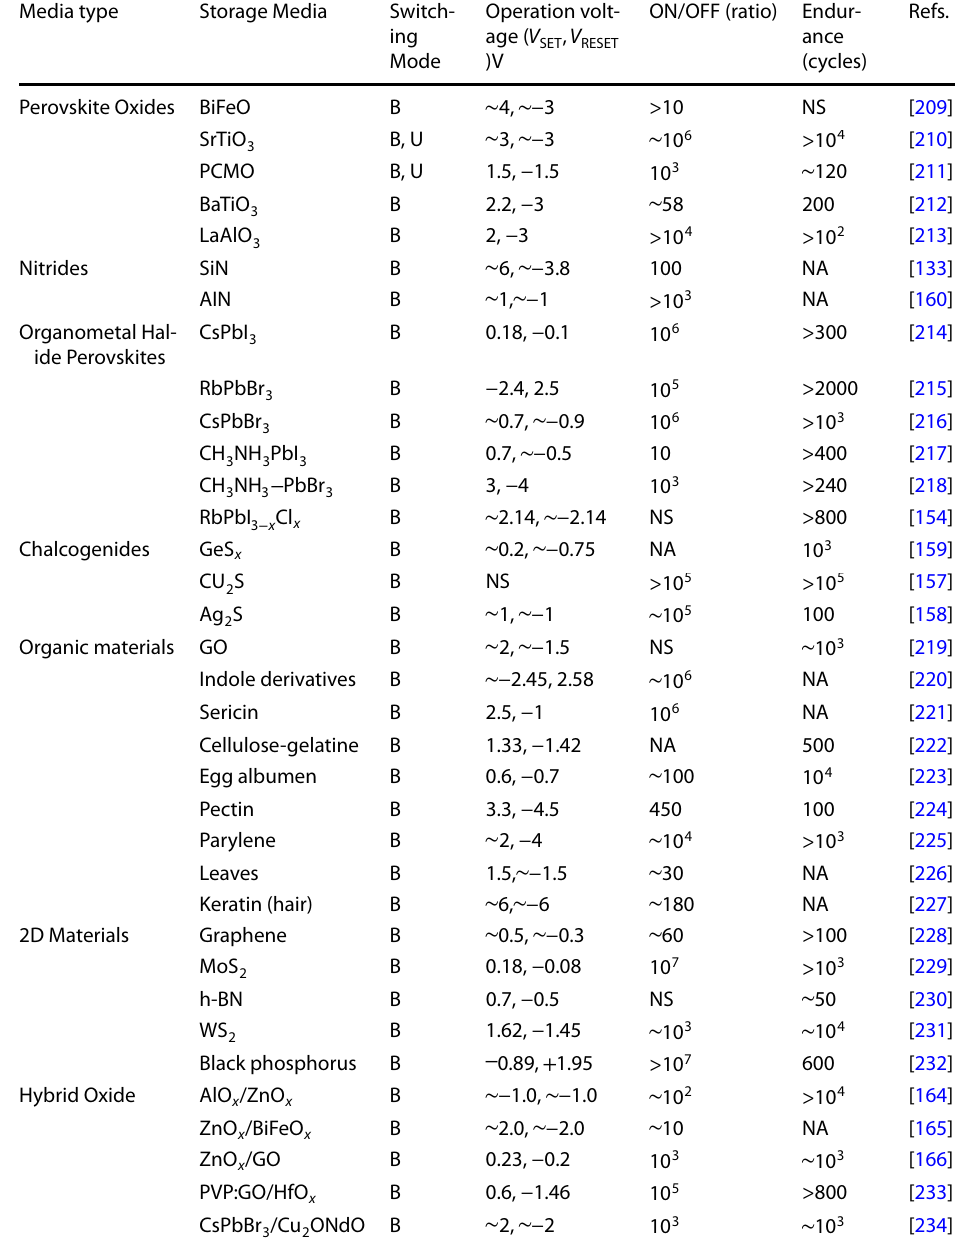
Table 2 Summary of the switching properties of some other dielectric